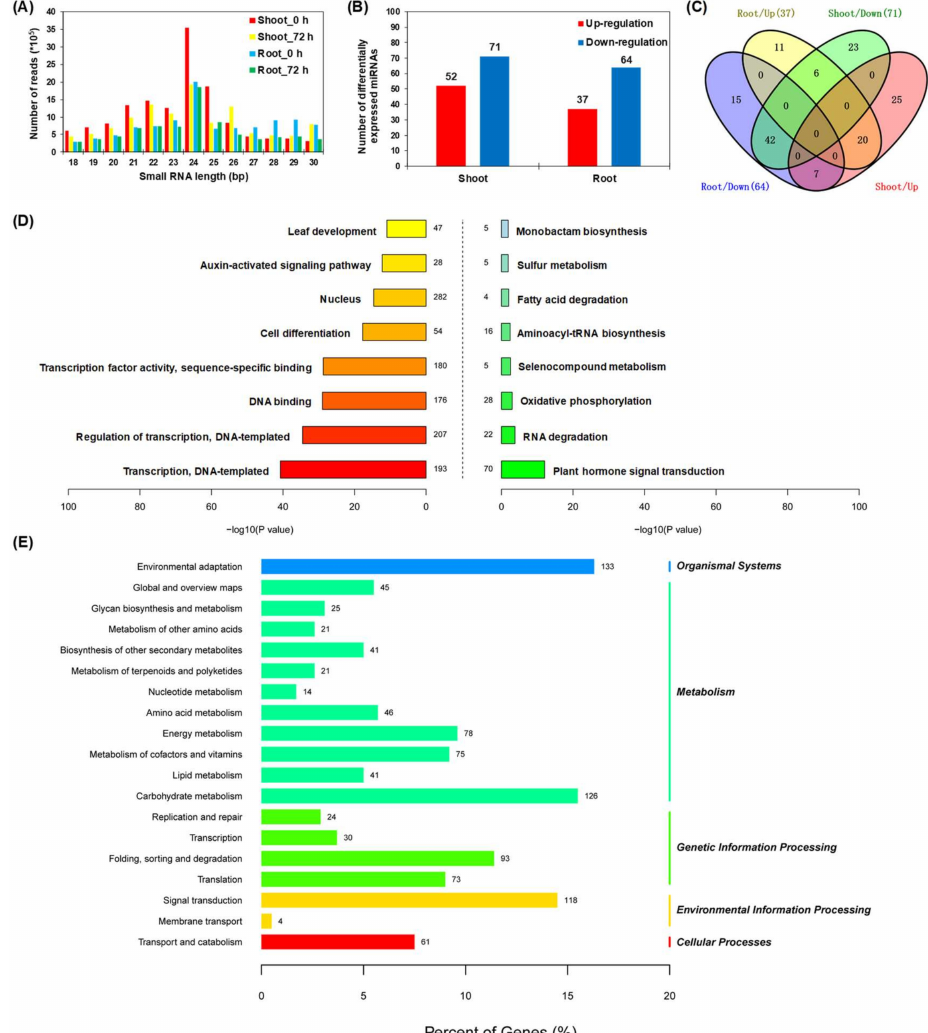
Figure 6. Molecular characterization of di ff erentially expressed miRNAs in response to N limitation. ( A ) Length distribution of miRNAs in di ff erent sample libraries. ( B ) Number of di ff erentially expressed miRNAs in the shoots and roots. ( C ) Venn diagram of di ff erentially expressed miRNAs. Digit in each circle represented the number of di ff erentially expressed miRNAs in the corresponding sample, and digit in the overlapping circle part represented the number of co-expressed miRNAs between di ff erent samples. ( D ) Gene Ontology and ( E ) KEGG pathway enrichment analysis of the genes targeted by di ff erentially expressed miRNAs. In ( D ), x - and y -axis refers to the values of corrected − log 10 ( p -value) and the number of genes targeted by di ff erentially expressed miRNAs, respectively. In ( E ), x - and y -axis refers to the percentage of each category genes accounting for all the genes targeted by di ff erentially expressed miRNAs and the target gene number. The times of 0 h and 72 h refer to the times after treatment of N